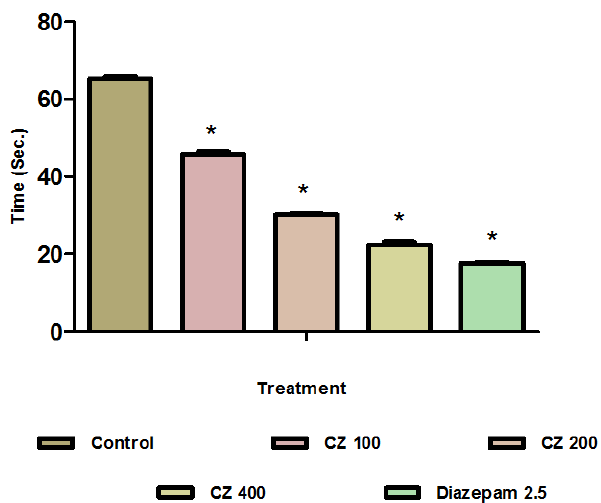
Fig. 8. Effect of EECZ on total duration of fighting against resi- dent intruder. Control = 6 and treatment extract n=6, * p <0.001 compared to